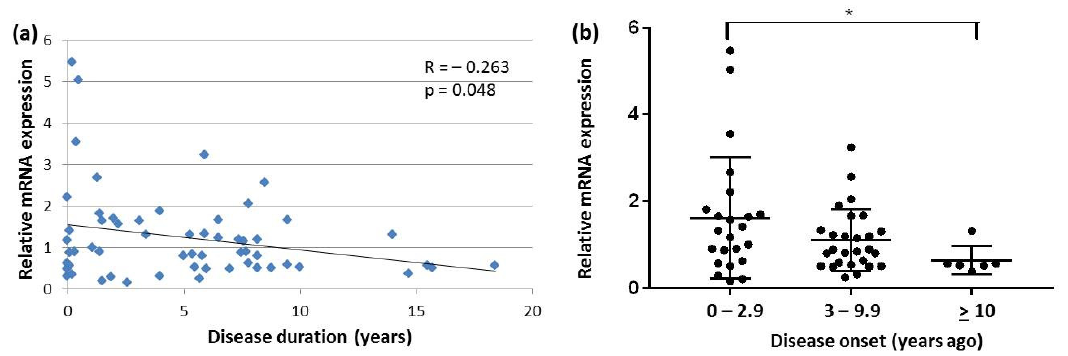
Figure 4. SNCAtv3 expression in blood of PD patients: ( a ) correlation between SNCAtv3 expression and disease duration; ( b ) comparison of SNCAtv3 expression levels in three PD groups with different disease duration. * p < 0.05.